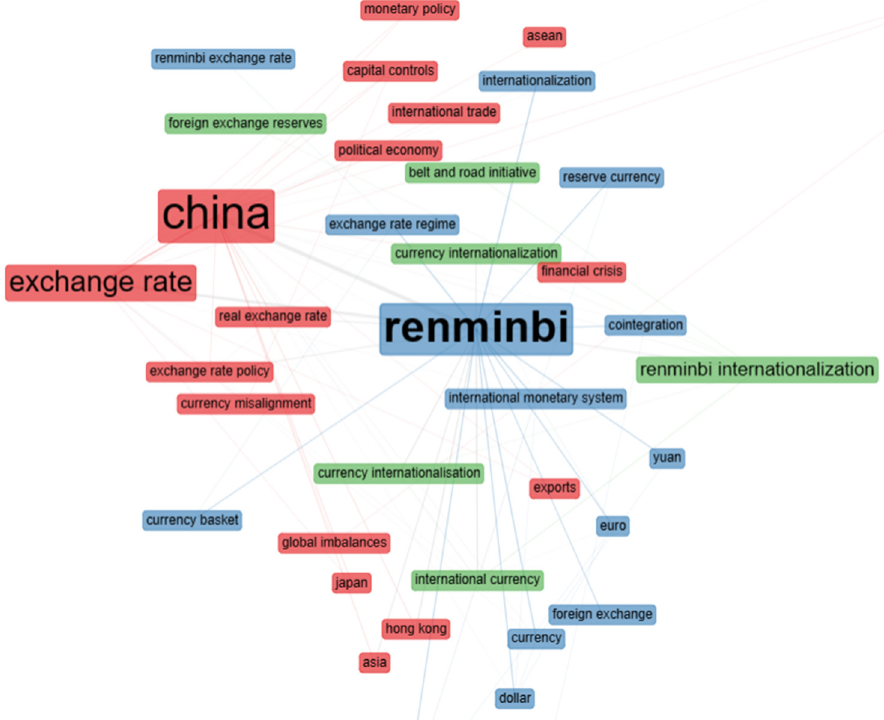
Figure 7. Co-occurrence network of authors’ keywords. Source: Authors’ elaboration using Biblioshiny.